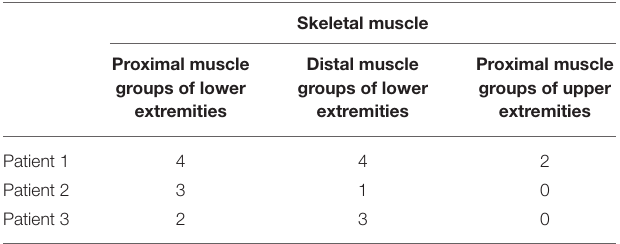
TABLE 1 | Fatty infiltration of the muscles on magnetic resonance imaging (MRI) using the semiquantitative method ( 29). Skeletal